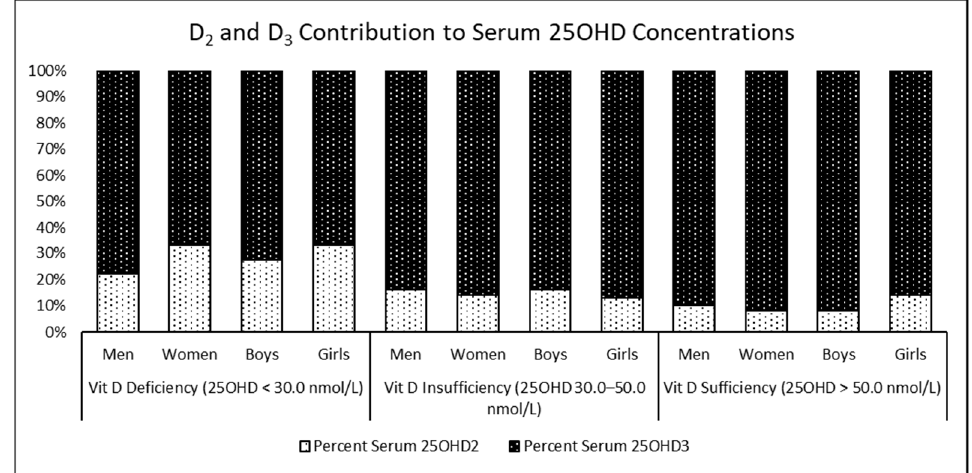
Figure 2. Contribution of D 2 and D 3 to total serum 25OHD concentrations stratified by vitamin D status, gender, and age.